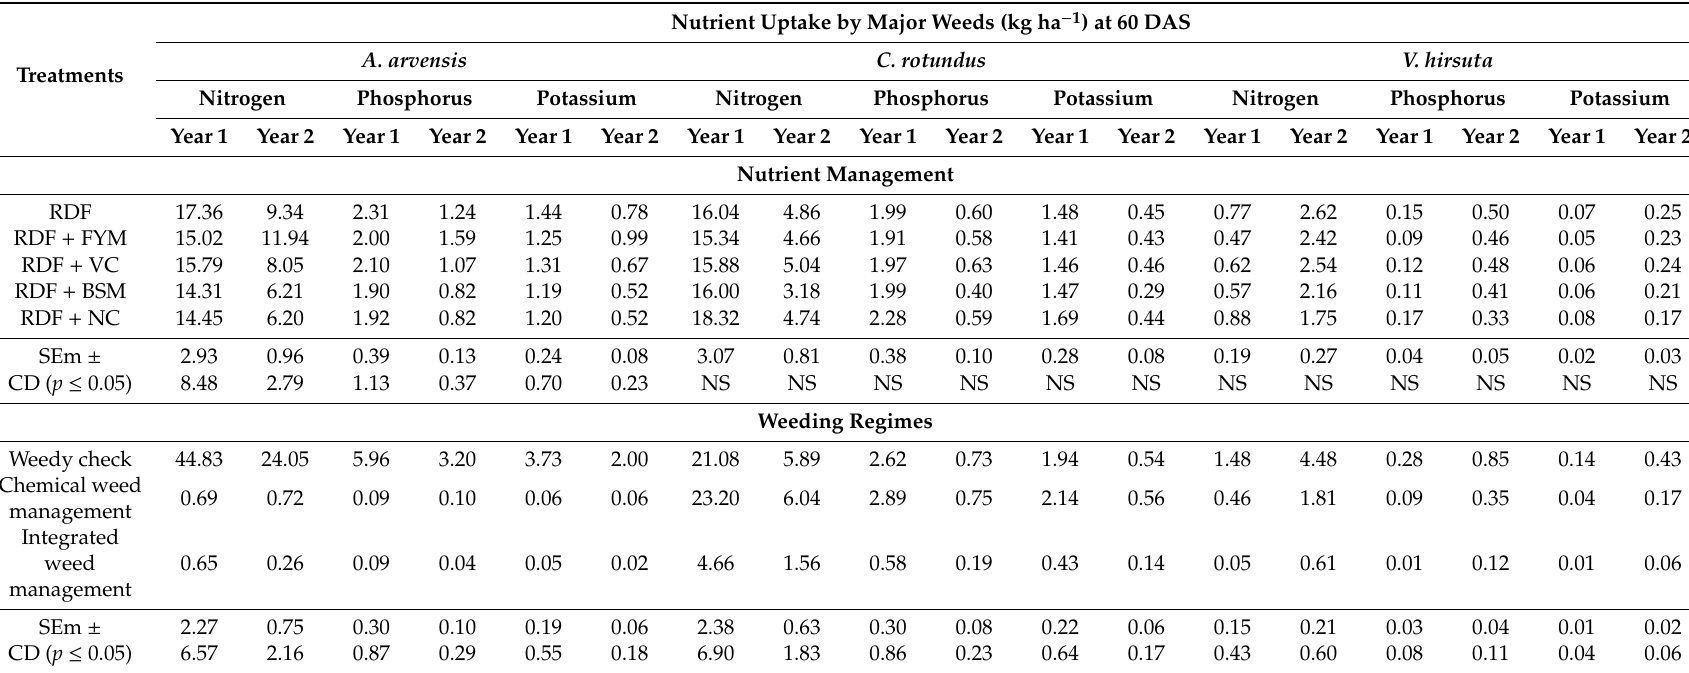
Table 3. E ff ect of di ff erent nutrient managements and weeding regimes on nutrient uptake by major weeds (kg ha − 1 ) at 60 DAS in hybrid maize.